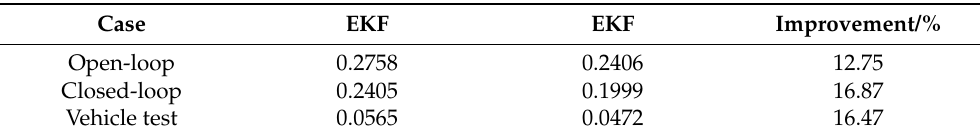
Figure 12. The observation and residual in the open-loop test. Table 1. RMSE of residual.